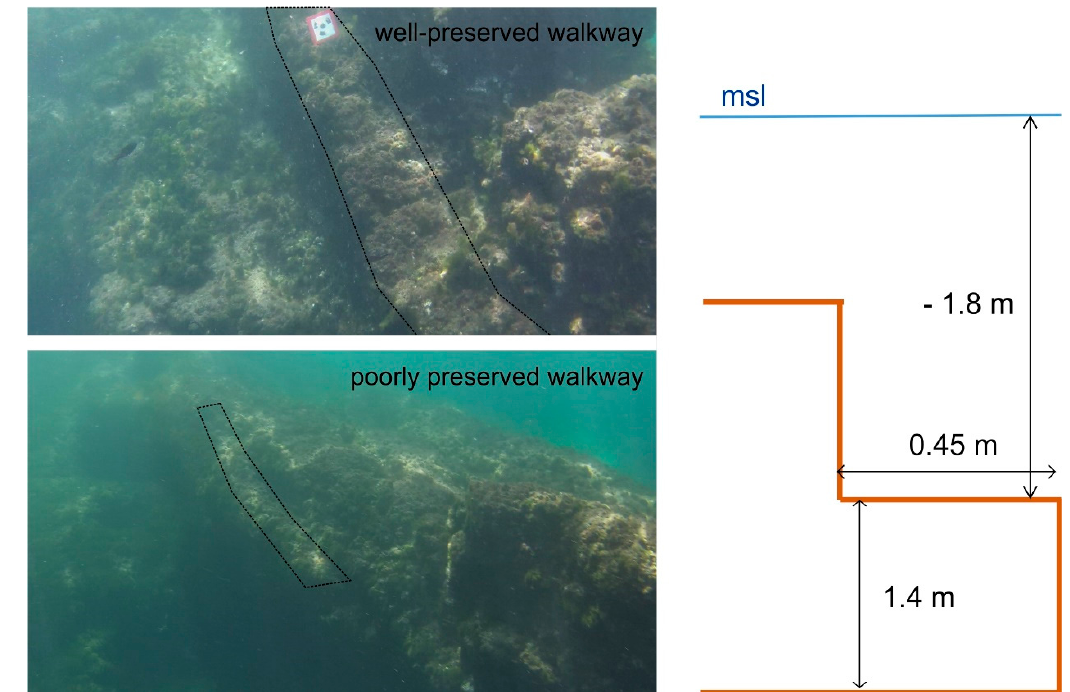
Figure 14. Measurements of the channel dimensions and submersion: ( a ) channel #01; ( b) channel #02; ( c) channel #03.